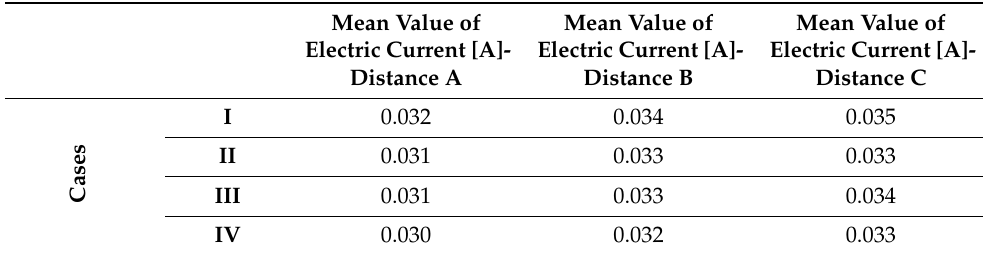
Table 2. Mean value of electric current.